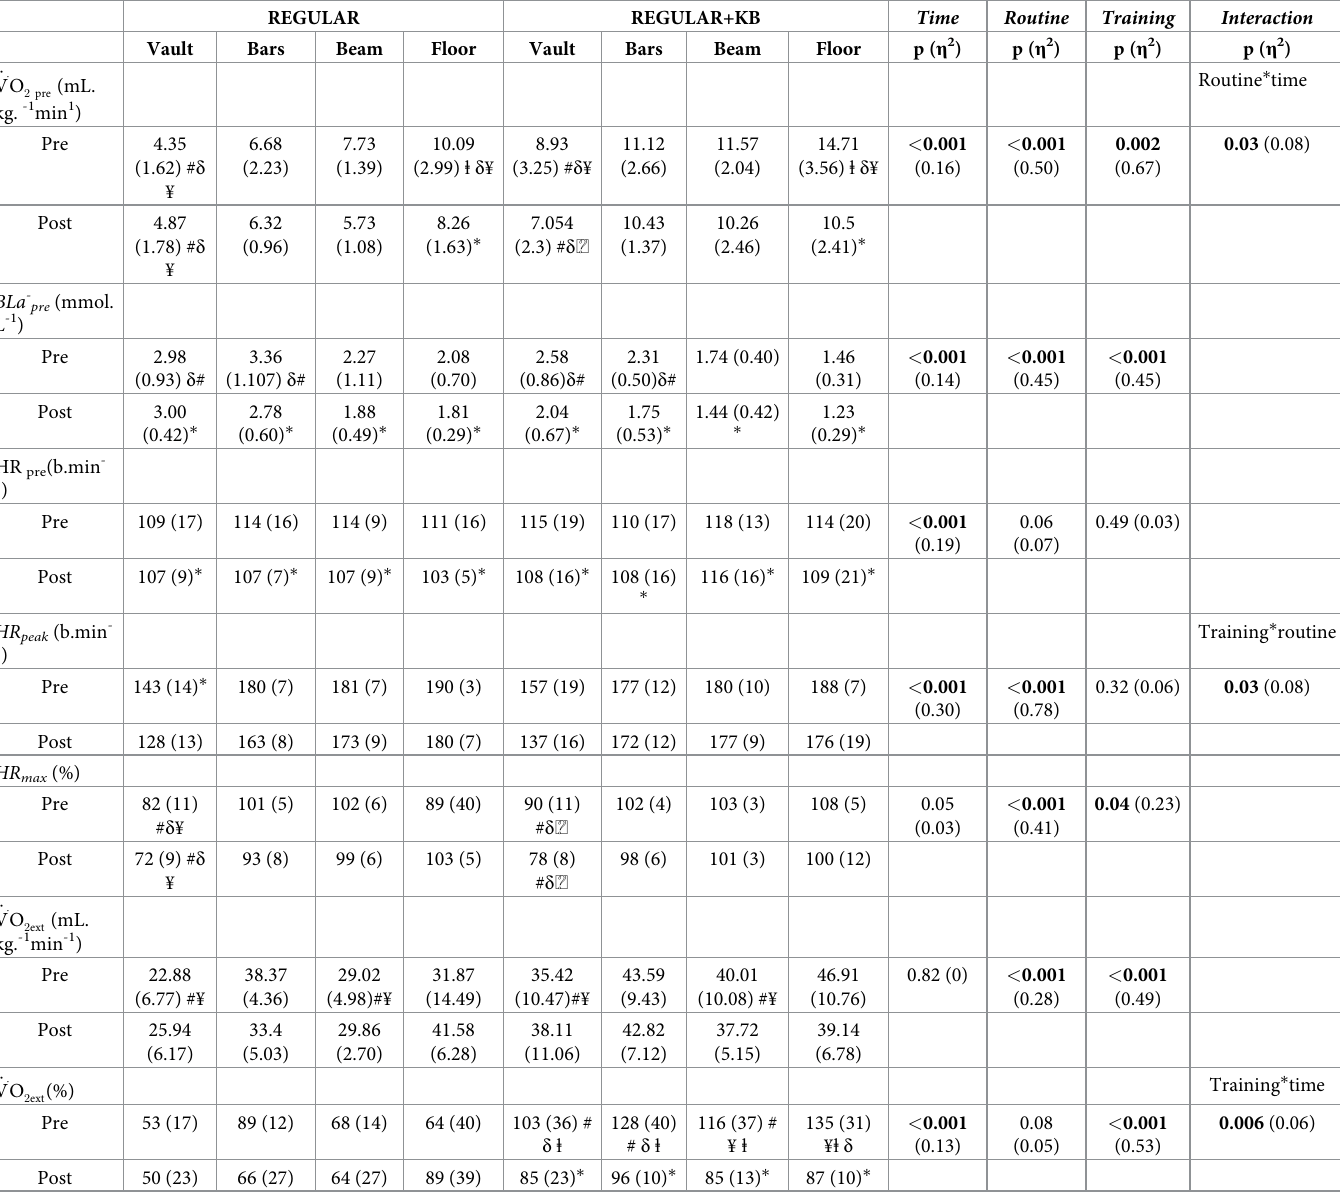
Table 2. Effects of exercise training protocols on oxygen uptake, blood lactate, and heart rate before and during female artistic gymnastics routines. REGULAR Routine Training